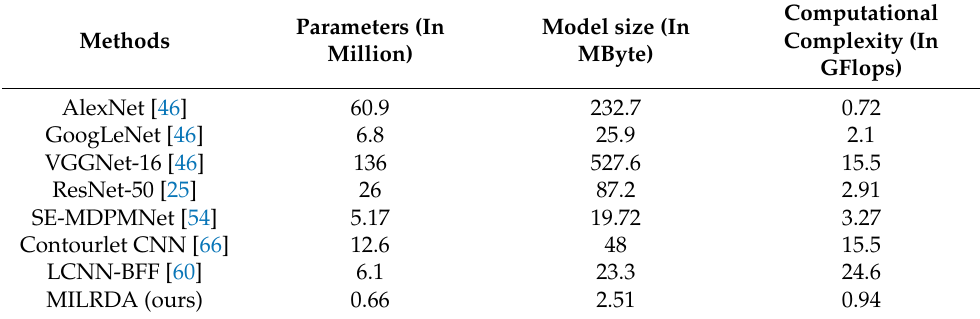
Table 7. Comparing the size and complexity of different models.